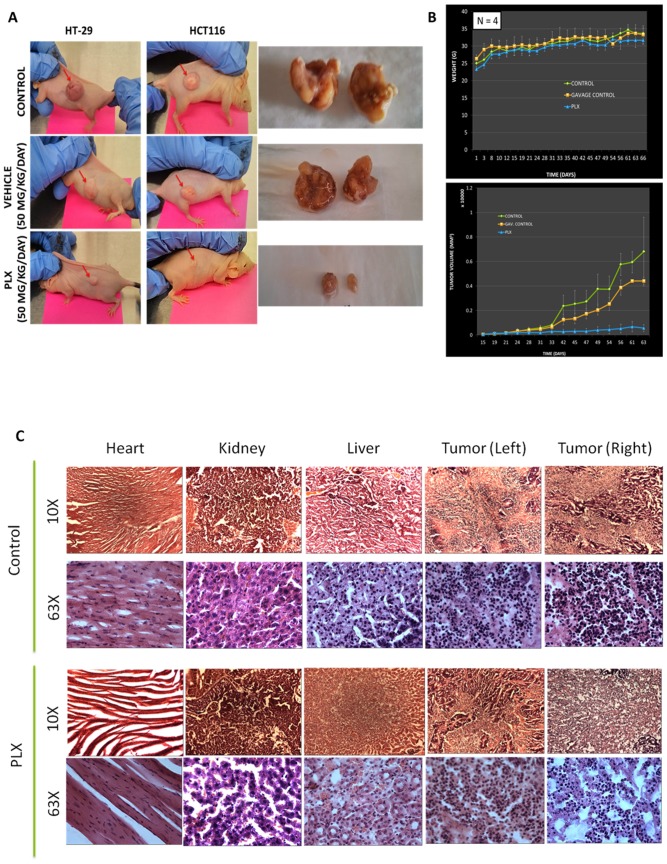
PLX Halts Growth of Colon Tumors in Xenograft Models.CD-1 nu/nu mice were subcutaneously injected with colon cancer cells; HT-29 (p53−/−) on the left flank and HCT116 (p53+/+) on the right flank. (A) Representative tumor size control mice and 50 mg/kg/day vehicle or PLX treated mice, respectively. PLX halted the growth of both HT-29 and HCT116 tumors in-vivo. (B) Average body weights of control and PLX treated mice. The body weights did not vary significantly during the study. Tumor volumes were measured and tumor curve shows the efficacy of 50 mg/kg/day oral administration of PLX. (C) Histopathological analysis of tissue samples obtained from control and PLX-treated animals. Hematoxylin and Eosin stained tissue sections of the livers, hearts, kidneys and tumors. Images were obtained on a bright field microscope at 10× and 63× objective.